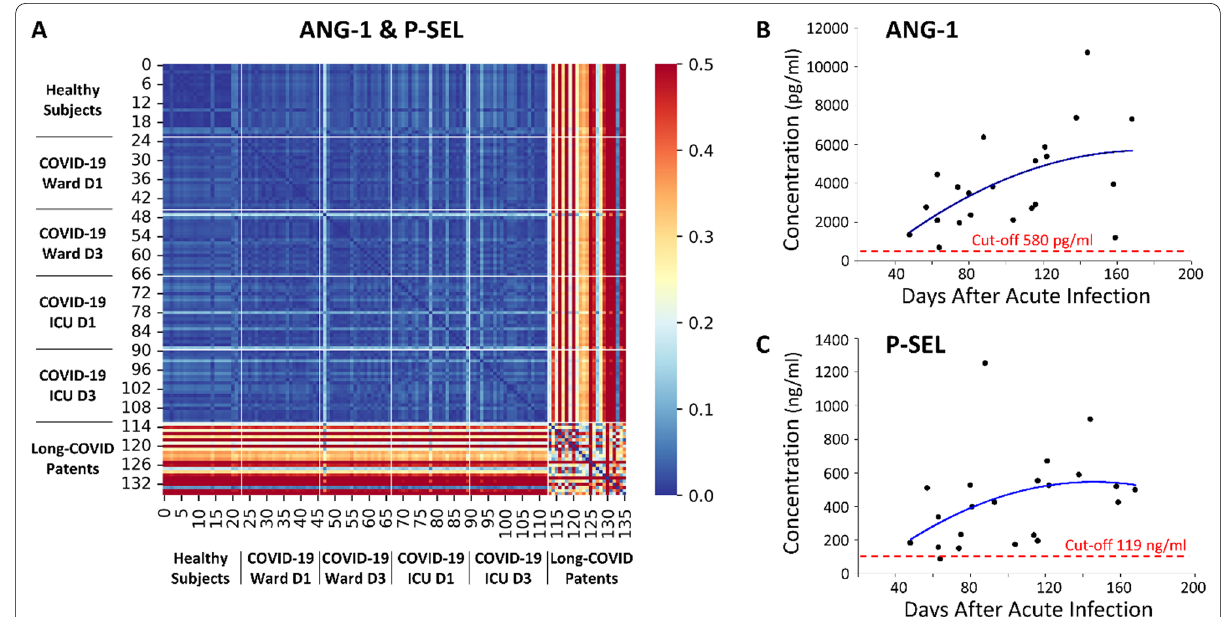
Fig. 2 Similar biomarker profiles and plasma concentrations relative to days after acute infection. A A heatmap demonstrated the pairwise Euclidian Distance between cohort’s biomarker profiles with respect to ANG-1 and P-SEL. Lower distances between patients indicate similar biomarker profiles while larger distances indicate large differences between profiles (distance was pseudocolored on the bar scale). The biomarker profile of Long-COVID outpatients is distinctively different from all other cohorts. The heatmap color scale was capped at 0.5 to restrict interpretation bias from Long-COVID outliers (max value 1.2) and allow for more visible details. B A plot demonstrated ANG-1 concentration versus time after acute infection. A cut-off value, adopted from previous ROC analyses on multiplex data, and a best fit polynomial regression line were calculated. C A plot demonstrated P-SEL concentration versus time after acute infection. A cut-off value, adopted from previous ROC analyses on multiplex data, and a best fit polynomial regression line were